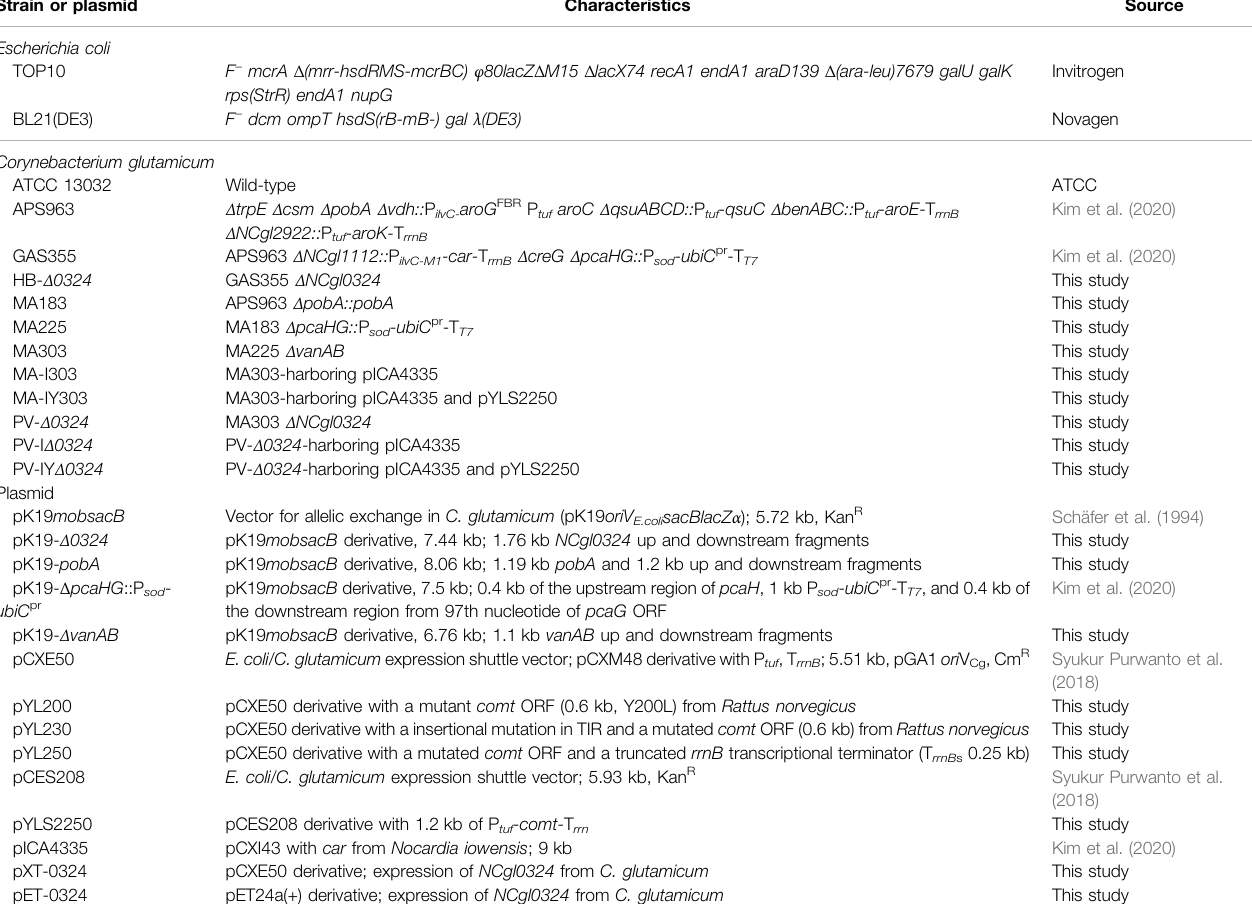
TABLE 1 | Bacterial strains and plasmid list used in this study. Strain or plasmid